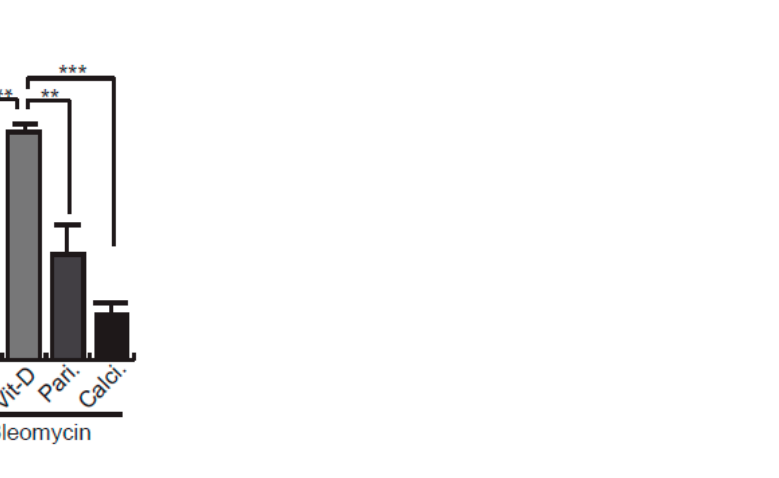
Figure 2. Effects of vitamin D and two hypocalcemic analogs in the expression of DNA damage induced by bleomycin in A549 cells. ( A ) Basal expression of DSBs (TP53BP1 foci (red dots)) induced by vitamin D and the analogs paricalcitol and calcipotriol in the absence of bleomycin. A549 cells were treated with 50 nmol/L vitamin D (or the corresponding analog) for 48 h and then subjected to immunofluorescence to detect DD foci. Representative micrographs are shown. PBS is the bleomycin vehicle; vehicle: vitamin D or analogs vehicle; scale bar: 10 μ m. ( B ) Quantification of damaged cells (nuclei with TP53BP1 foci). Data from three experiments are represented; more than 150 cells per condition were analyzed. ANOVA p < 0.001. ( C ) Expression of TP53BP1 foci (red dots) in cultures of A549 cells pre-treated with 50 nmol/L vitamin D, analogs or its vehicle for 2 h and subjected to a bleomycin shock (12 μ g/mL) for 6 h. After that, the cultures were treated with 50 nmol/L vitamin D and the analogs paricalcitol and calcipotriol (or vehicle) for 48 h. Representative micrographs taken at 48 h post-shock are shown. Scale bar: 10 μ m. ( D ) Quantification of damaged cells; veh.: vitamin D or analogs vehicle. Data from three experiments are represented; more than 150 cells per condition were analyzed; ANOVA p < 0.001. The results presented in the figures are means ± SEM. Significance of the analysis is indicated as *: p < 0.05, **: p < 0.01, ***: p < 0.001.